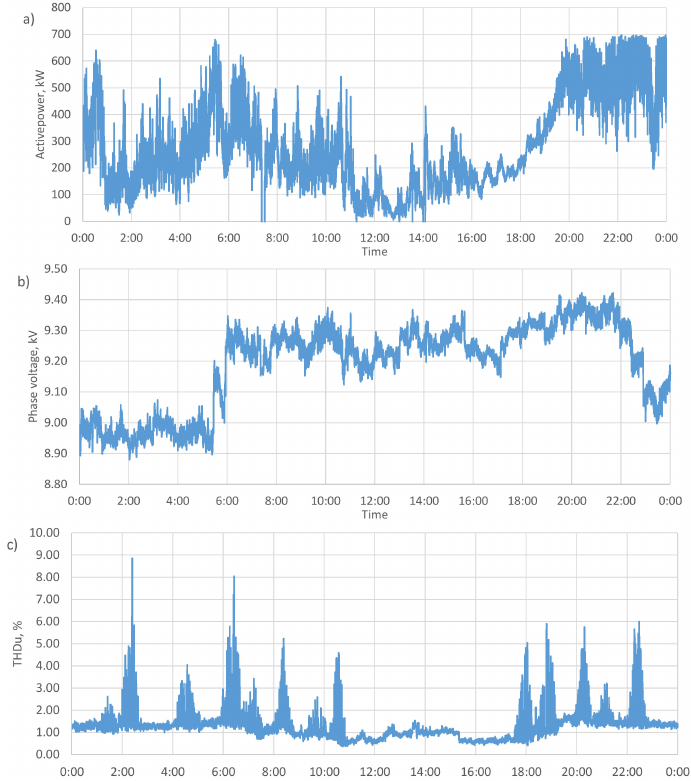
Figure 18. Exemplary one-day waveforms for the wind farm: ( a ) active power, ( b ) phase voltage—RMS value; ( c ) voltage